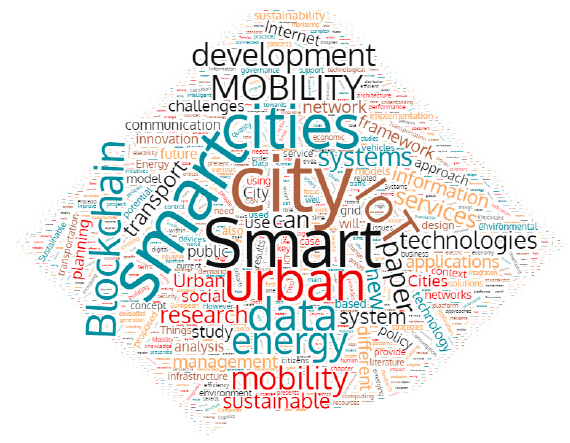
Figure 3. Word cloud of search query results.